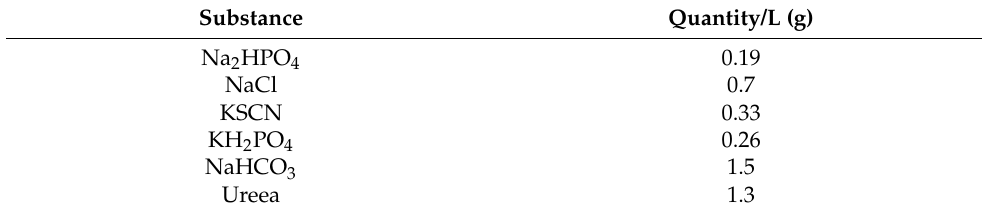
Table 3. Chemical composition of Carter Brugirard artificial